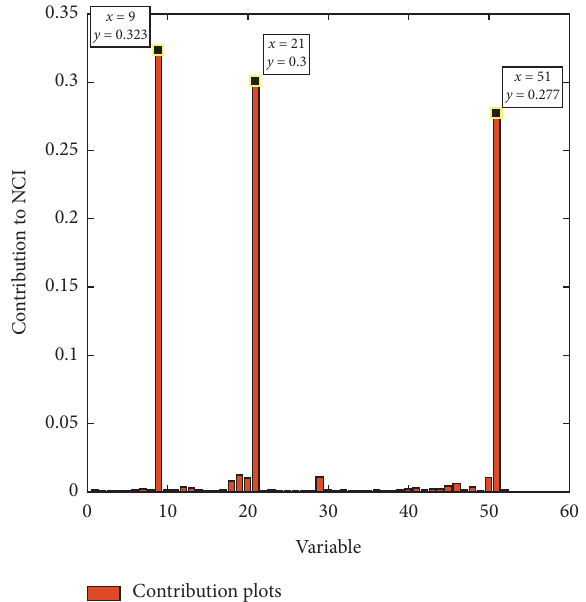
Figure 6: NCI-based contribution plot for fault 14.